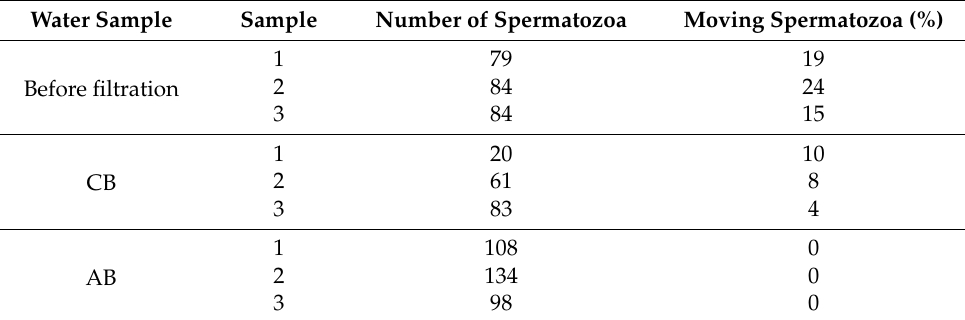
Table 10. Spermatozoa